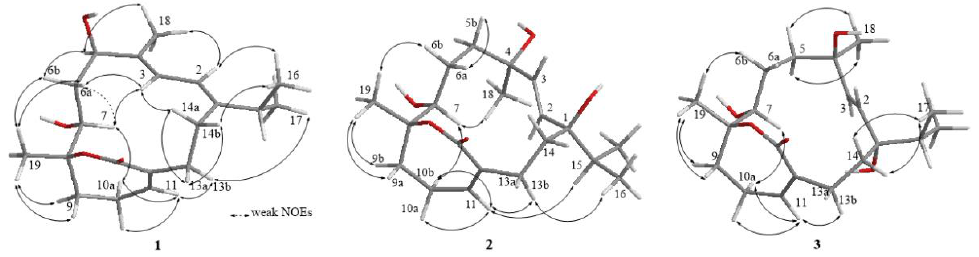
Figure 2. Selected NOE correlations of 1 – 3 .